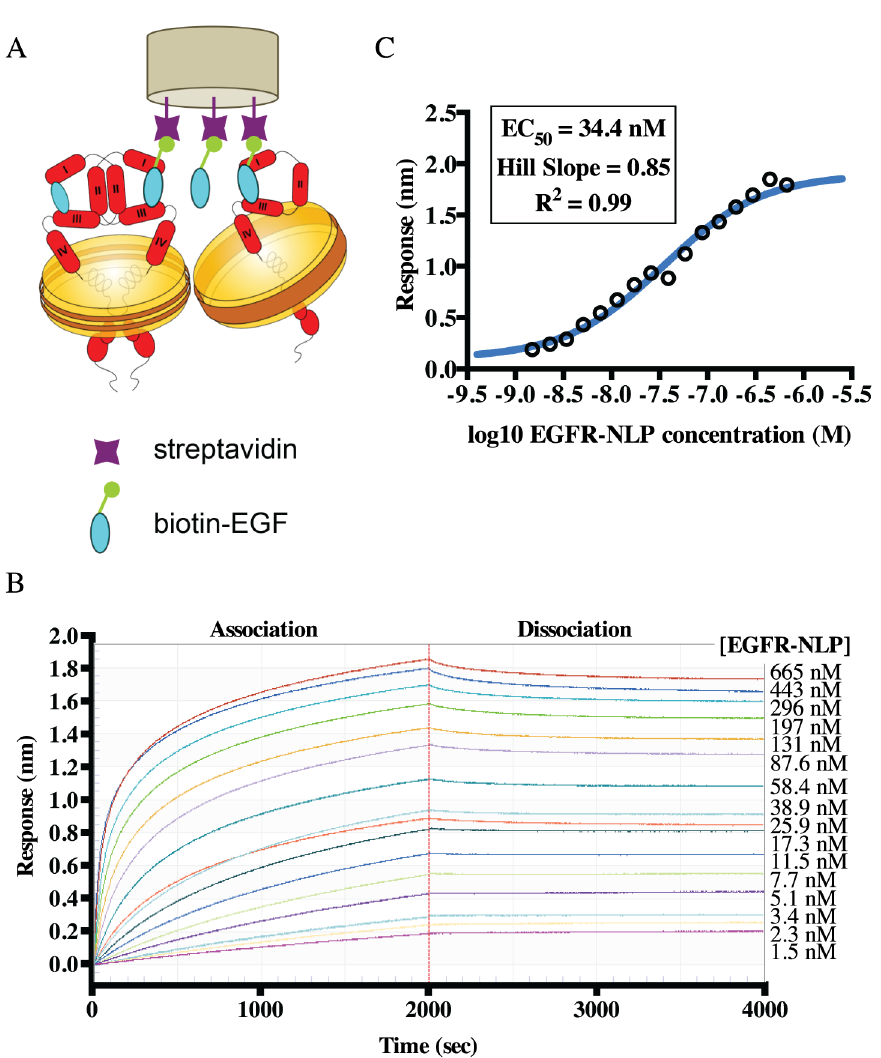
Fig 4. NLP-associated EGFR is capable of binding its ligand, EGF. A , Schematic of the OctetRed assay used to determineEGFR ligandbinding.Streptavidin biosensorswere loadedwith biotinylated EGF and EGFR-NLP associationand dissociationwith the sensor was quantitated via BLI. B , Association(0–2000s) and dissociation (2000–4000s) curves of EGFR-NLPs bindingto biotinylatedEGF on the sensors. EGFR- NLP concentrations were titrated by a 1.5-fold dilution to the concentrations displayedto the right of the graph. Curves are normalized by subtractingthe 0 μ M EGFR-NLP curve. C , Log plot of EGFR-NLP bindingresponse (nm) to biotinylated EGF. Plot shows mean of two technicalduplicates and are representative of results from three biological repeats. intestinal phosphatase (CIP) and then incubated the EGFR-NLPs with kinase buffer and ATP with or without kinase inhibitors. The EGFR-NLPs were able to autophosphorylate in the kinase buffer with and without additional EGF. This was not surprising because the EGFR- NLPs were assembled in the presence of EGF thus additional EGF does not increase phosphor- ylation levels. EGFR was also able to autophosphorylate in the presence of the HER2-specific inhibitor (mubritinib), but not in the presence of an EGFR-specific inhibitor (afatinib), a pan- ErbB inhibitor (canertinib), or an EGFR/HER2 inhibitor (lapatinib). These findings indicate that the EGFR in EGFR-NLPs was capable of kinase activity and can be used to screen inhibi- tors of autophosphorylation.